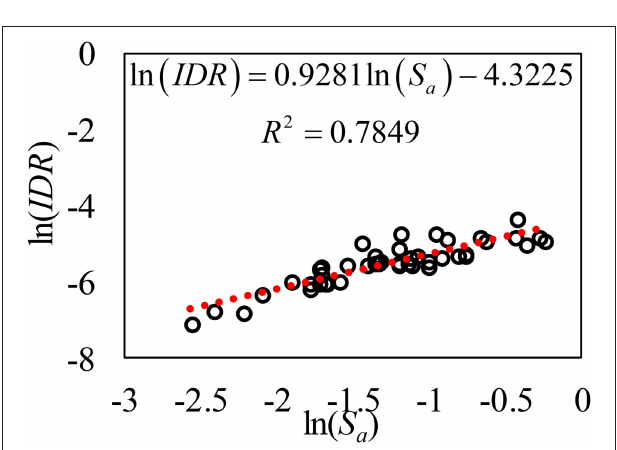
FIGURE 18 | Probabilistic seismic demand model.